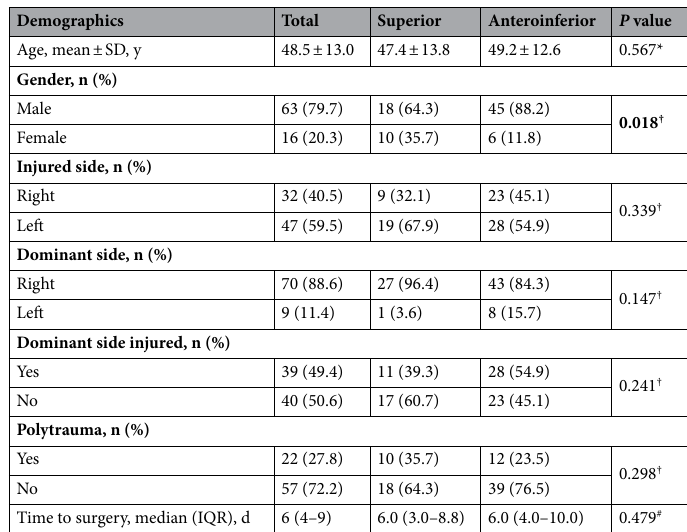
Table 1. Demographics of the patient cohort. Significant values are written in bold text. IQR: Interquartile range, SD: standard deviation, *: Independent t test, † : Fisher exact test, # : Mann–Whitney test.